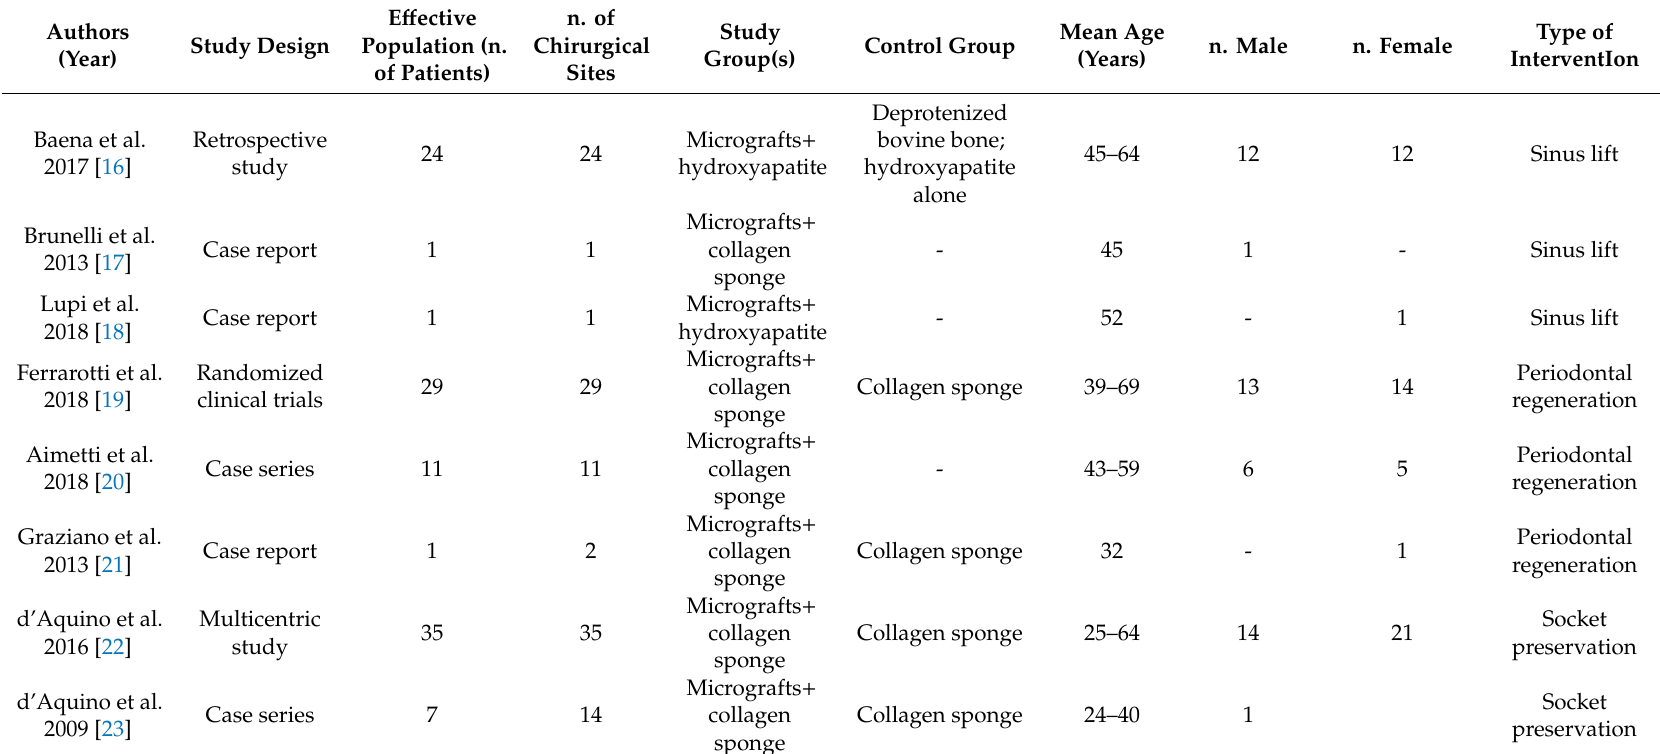
Table 1. Types of studies included in the